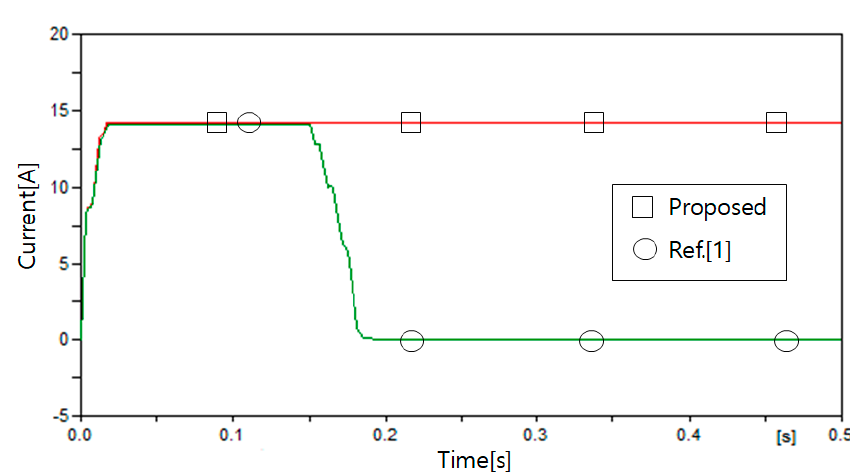
Figure 11. Current measured at I 1 in Case 2.